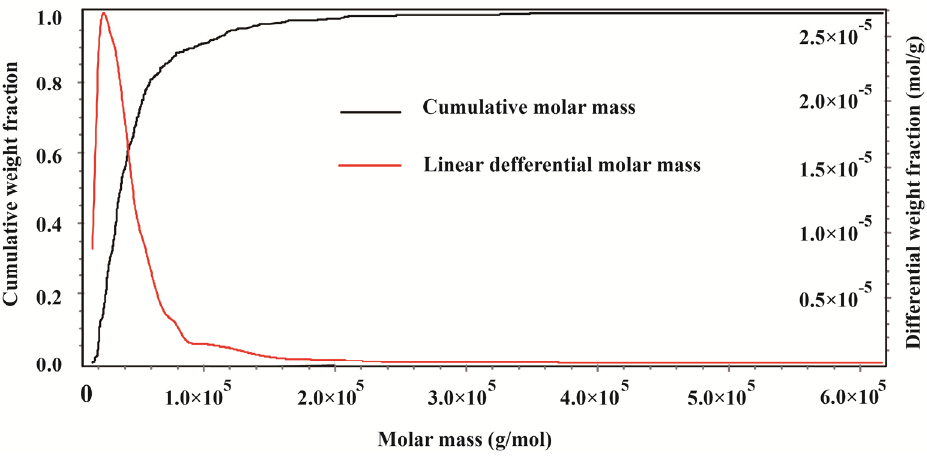
Figure 2. Molecular weight distribution obtained by gel permeation chromatogram for CMPE.